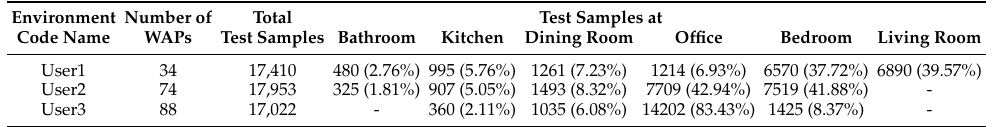
Table 2. Total number of different WAPs detected at each environment, and the number of samples taken in different